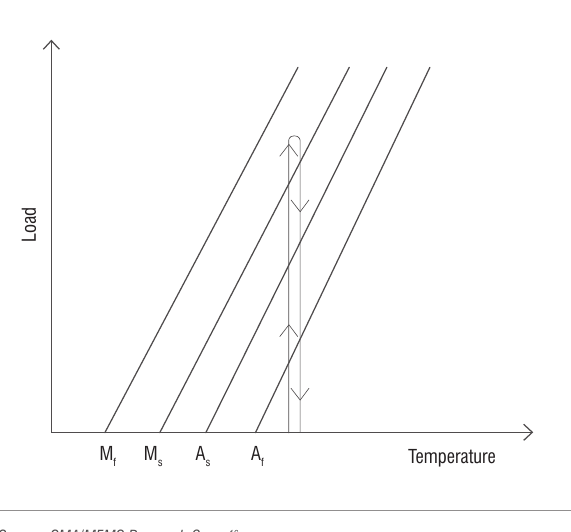
Figure 5: Load diagram of the pseudoelastic